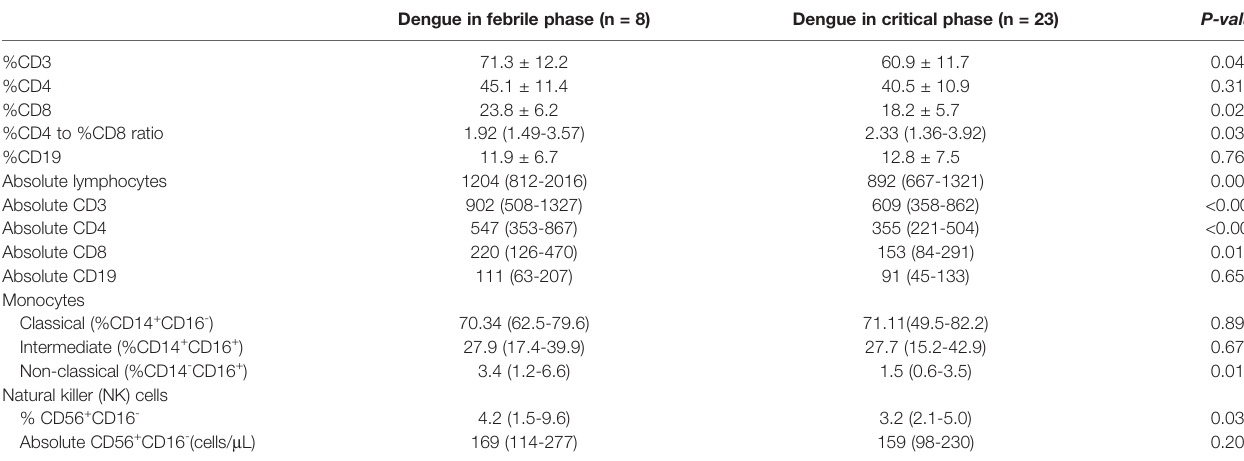
TABLE 2 | Comparisons of innate immunity parameters between dengue patients in febrile phase and critical phase.